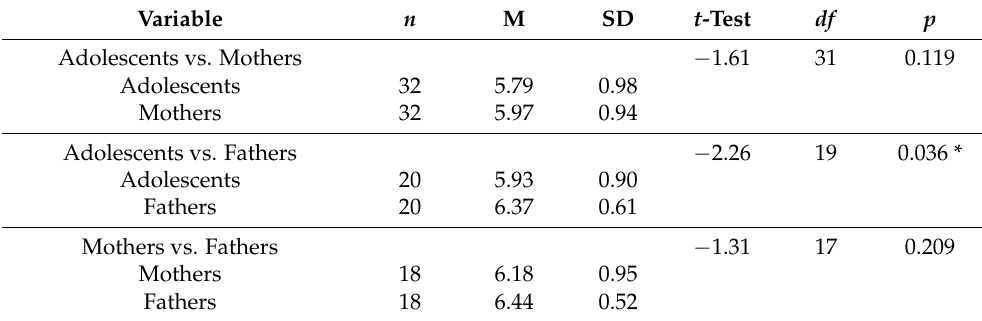
Table 3. Comparison of decision quality scores between adolescents, mothers, and